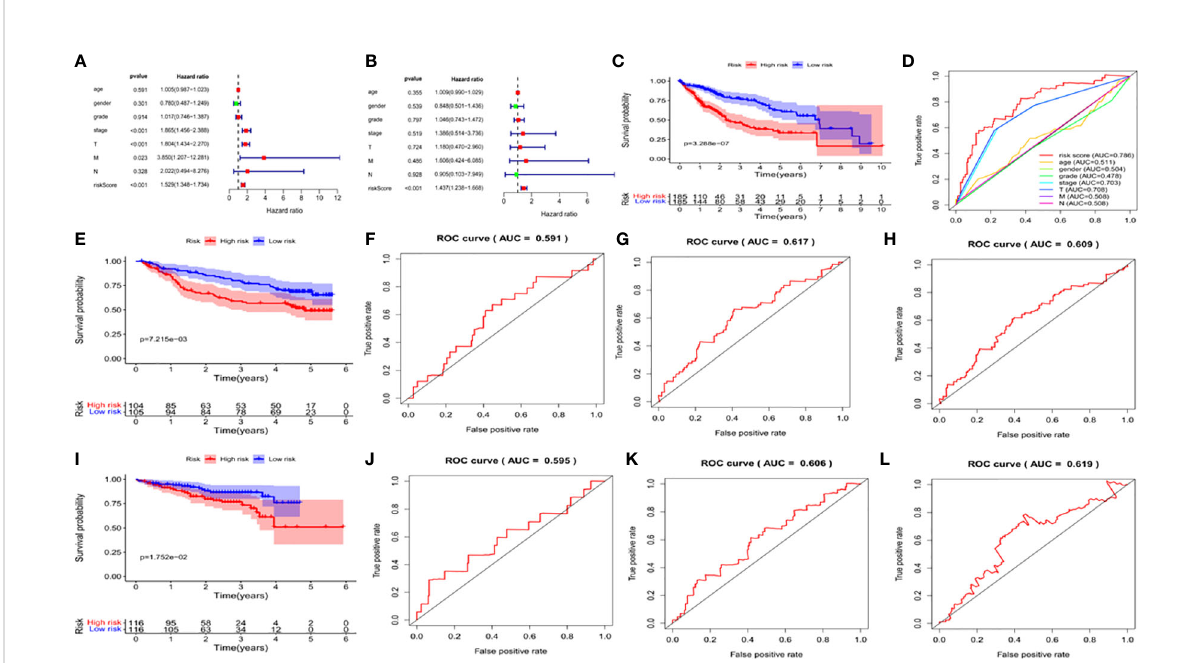
FIGURE 7 Validation of the prognostic signature of the 5 signature DEGs. (A) Forest plot shows the univariate Cox analysis of the relationship between the clinical features, risk score and OS of HCC patients in TCGA cohort. (B) Forest plot shows the multivariate Cox analysis of the relationship between the clinical features, risk score and OS of HCC patients in TCGA cohort. (C) Kaplan-Meier survival curve of patients with HCC in the High-risk and low-risk groups in TCGA dataset. The abscissa represents time (years), the ordinate represents survival probability. (D) ROC curve for predicting total survival time in TCGA dataset. The abscissa represents false positive rate, the ordinate represents true positive rate. (E) Kaplan-Meier survival curve of patients with HCC in the high-risk and low-risk groups in the GSE14520 dataset. The abscissa represents time (years), the ordinate represents survival probability. (F – H) The ROC curve for predicting the overall survival time of patients at 1, 3, and 5 years in the GSE14520 data set (I) Kaplan-Meier Survival Curve of patients with HCC in High-risk and low-risk groups in ICGC data set. (J – L) The ROC curve for predicting the overall survival time of patients at 1, 3, and 5 years in the ICGC data